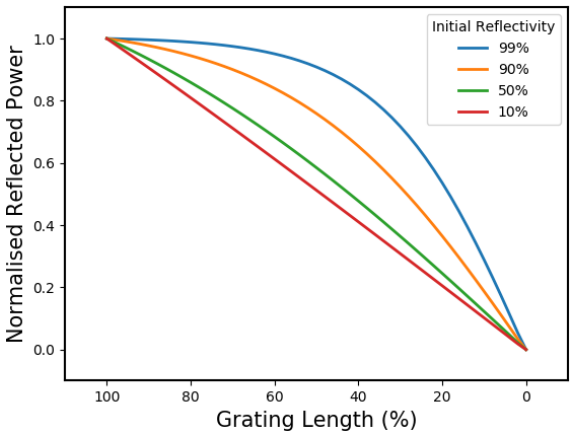
Figure 4. Graph showing how the total reflected power of a uniform grating (unapodised) depends on grating length and initial reflectivity. This is equivalent to an unapodised CFBG once it’s in the uniform grating regime.